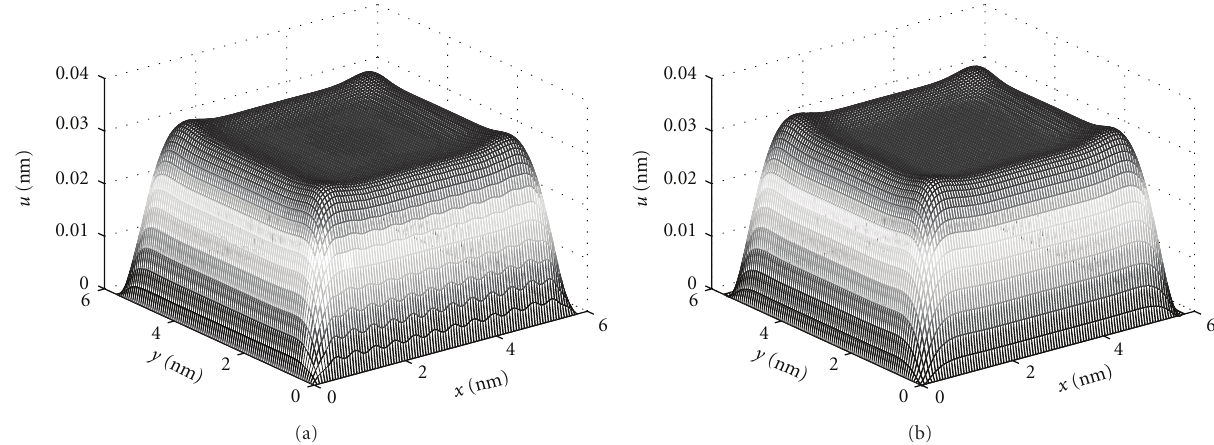
Figure 6: Interpolated atomistic simulation results (a) and continuum model solutions (b) with optimized α for a 6.4 nm by 6.8 nm graphene sheet with d = 0 . 31 nm and T = 0nN/nm.